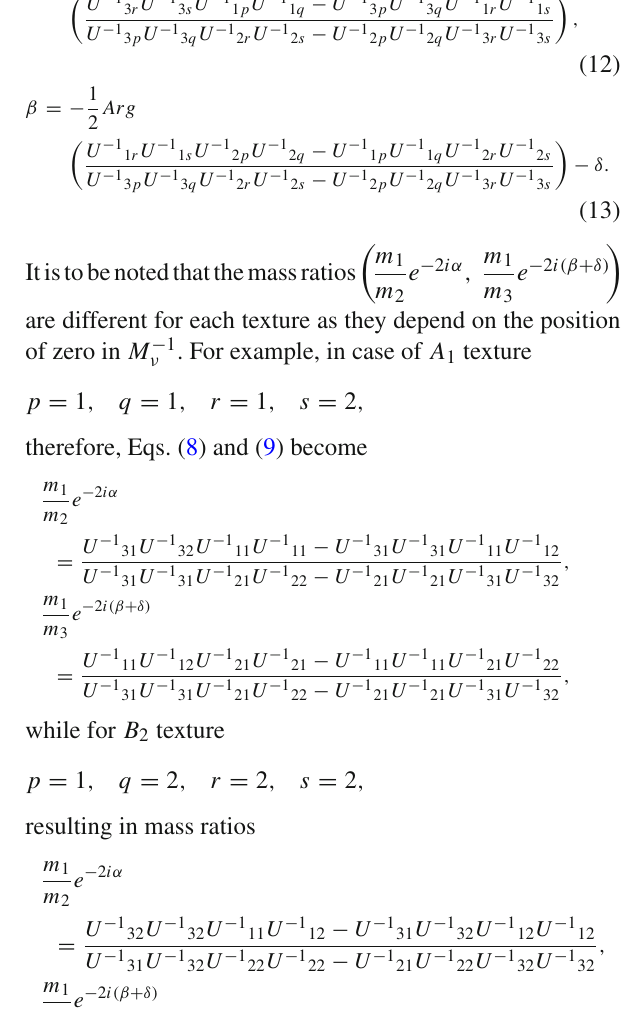
= m 2 − m 2 and 21 2 1 m 1